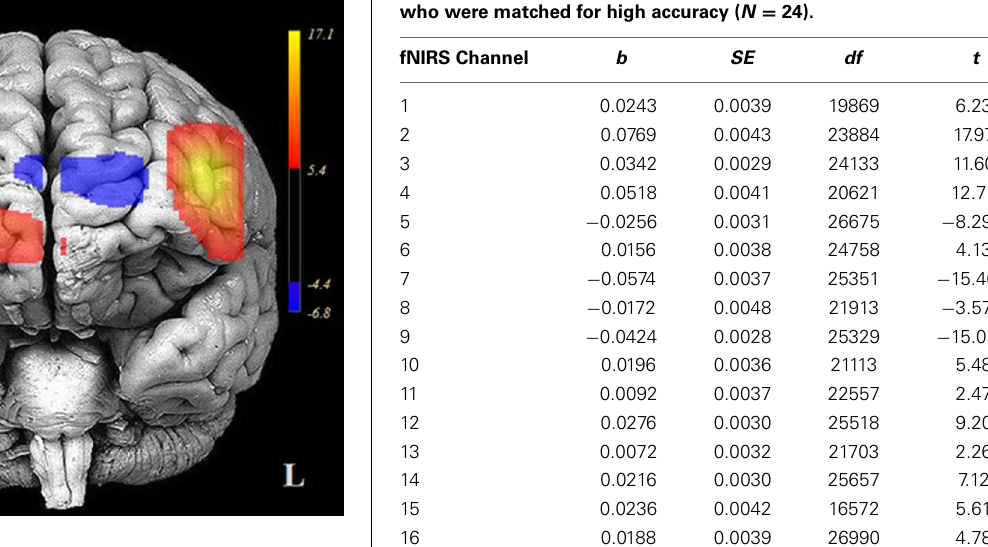
FIGURE 4 | Areas of significant activation and deactivation associated with solving two- and three-move problems on the Scarborough adaptation of the Tower of London (S-TOL) task for all participants ( N = 38). Areas of significant activation are denoted in red, and areas showing significant deactivation are in blue. Data represent t -scores for the contrast of multiple-move and zero-move conditions ( p < 0 . 05, False-Discovery Rate-corrected).